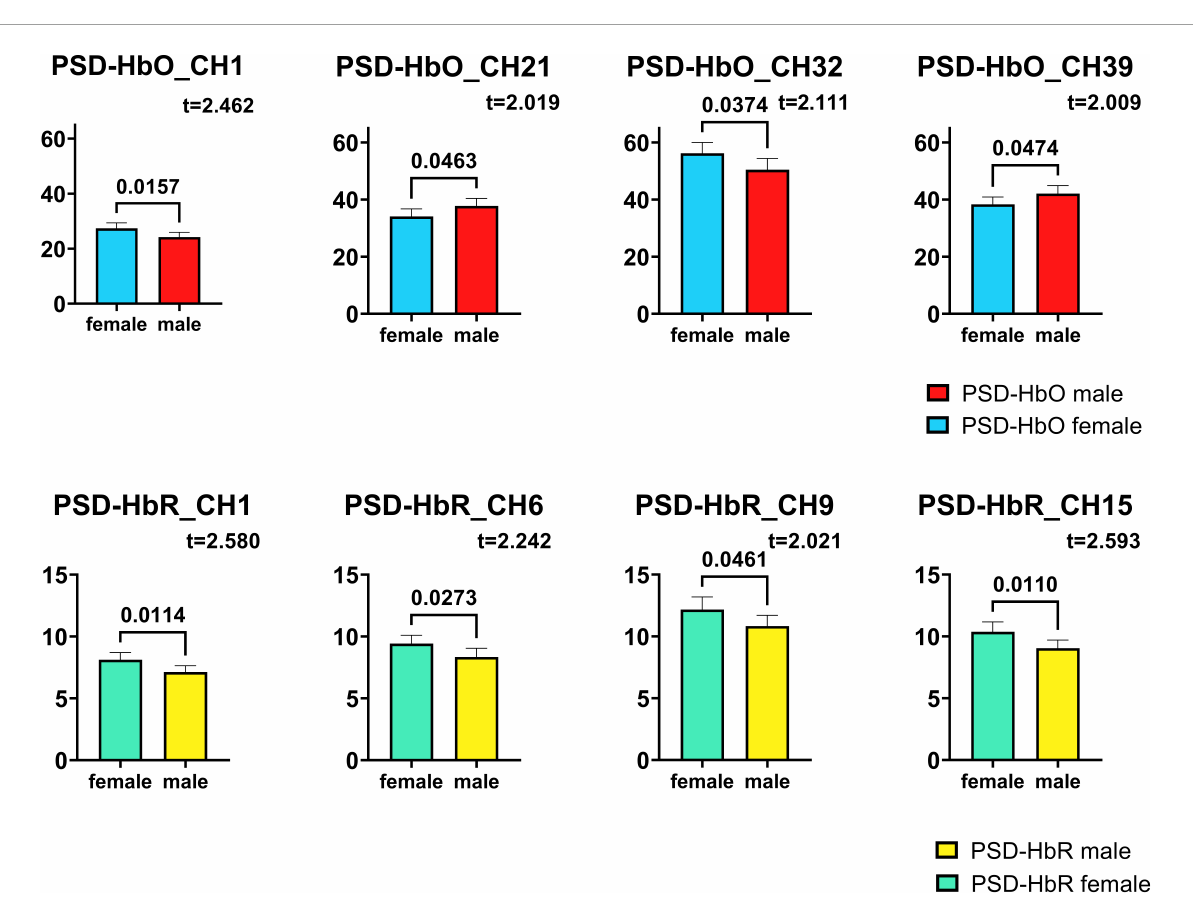
FIGURE5 Channels with significant differences in HbO, HbR PSD obtained by t -test. The numbers on the link line are the p -values in the t -test, and the t -values are also labeled in the figure.